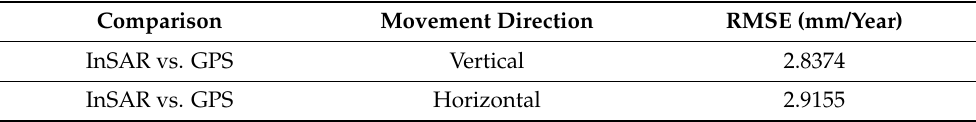
Table 2. Root mean square error (RMSE) values (in mm/year) for InSAR and GPS results. Comparison Movement Direction RMSE (mm/Year) InSAR vs. GPS Vertical 2.8374 InSAR vs. GPS Horizontal